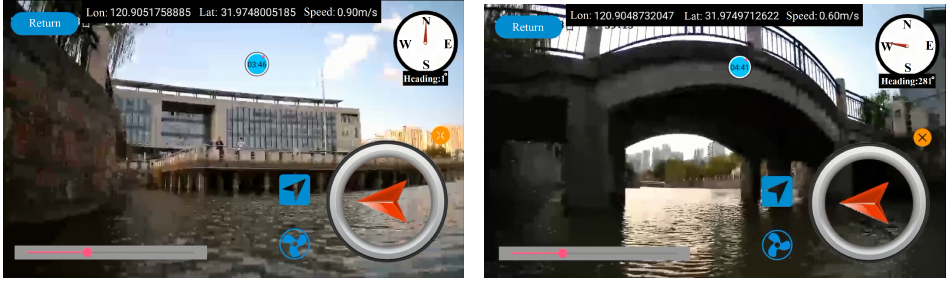
Figure 23. Live video from the